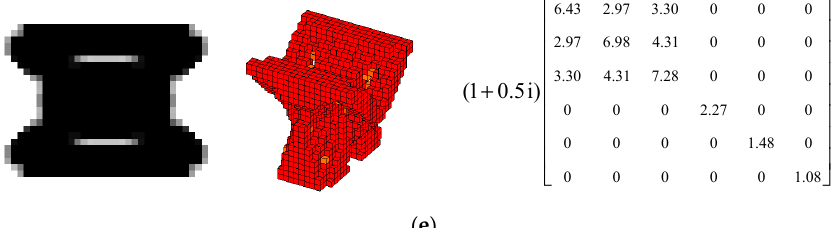
Figure 7. Optimization results obtained by varying the penalty factor: ( a ) p = 0; ( b ) p = 1; ( c ) p = 2; ( d ) p = 3; ( e ) p = 5.